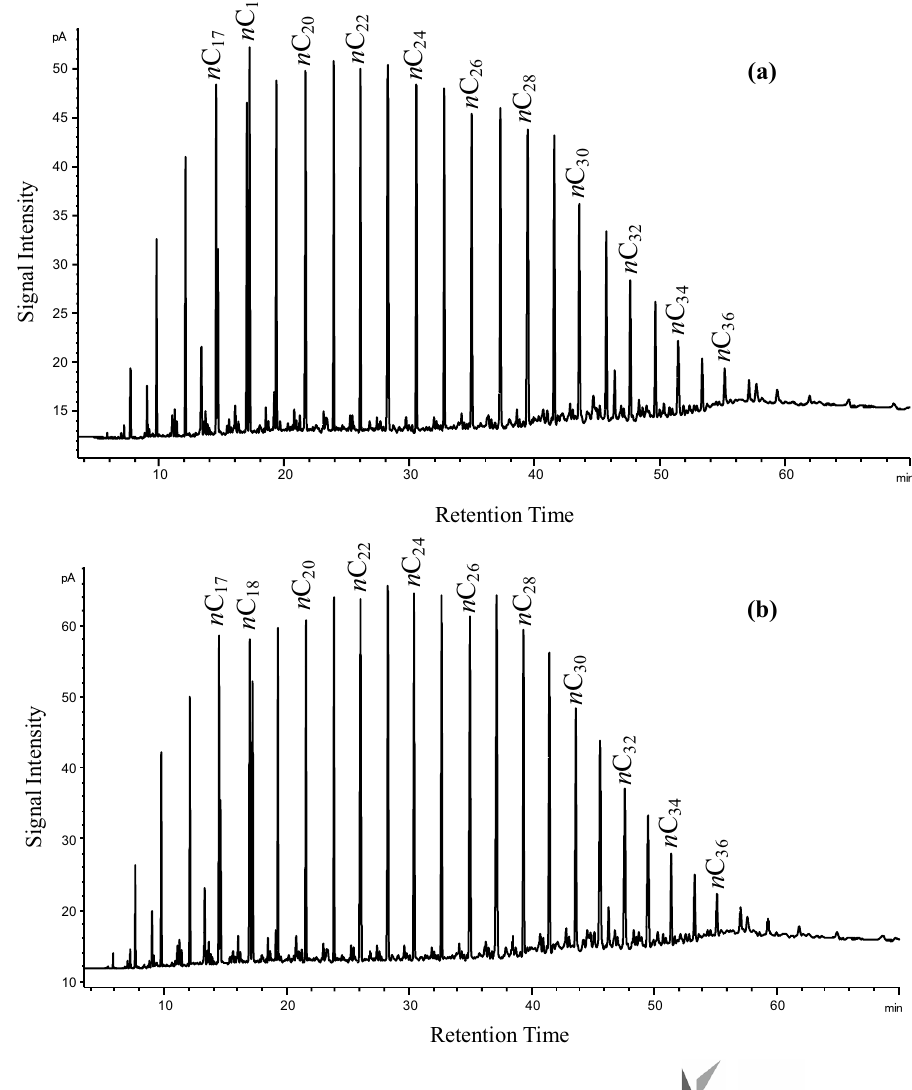
Fig. 2 The saturated hydro- carbon gas chromatography analyses of shale oil from well BYHF 1 ( a ) and well BYHF 2 ( b ) in Biyang